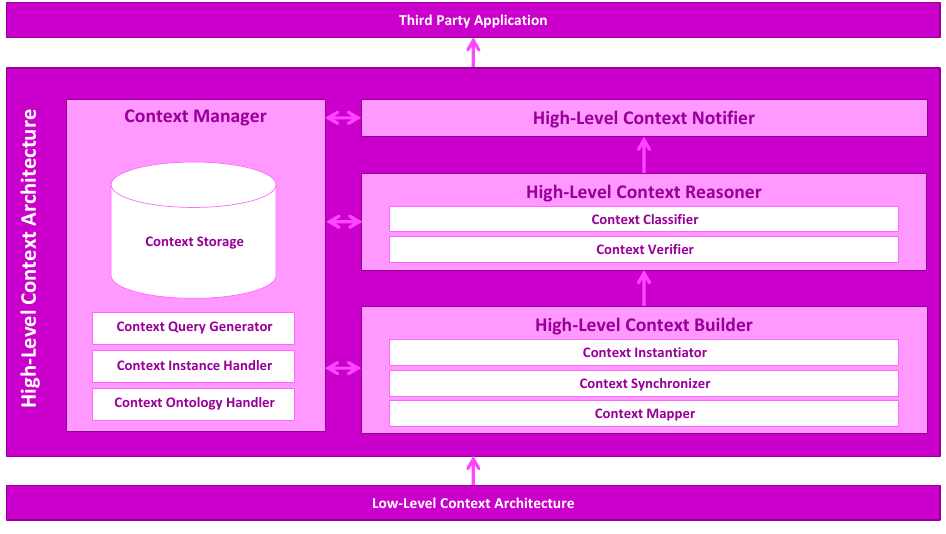
Figure 8. Mining Minds High-Level Context